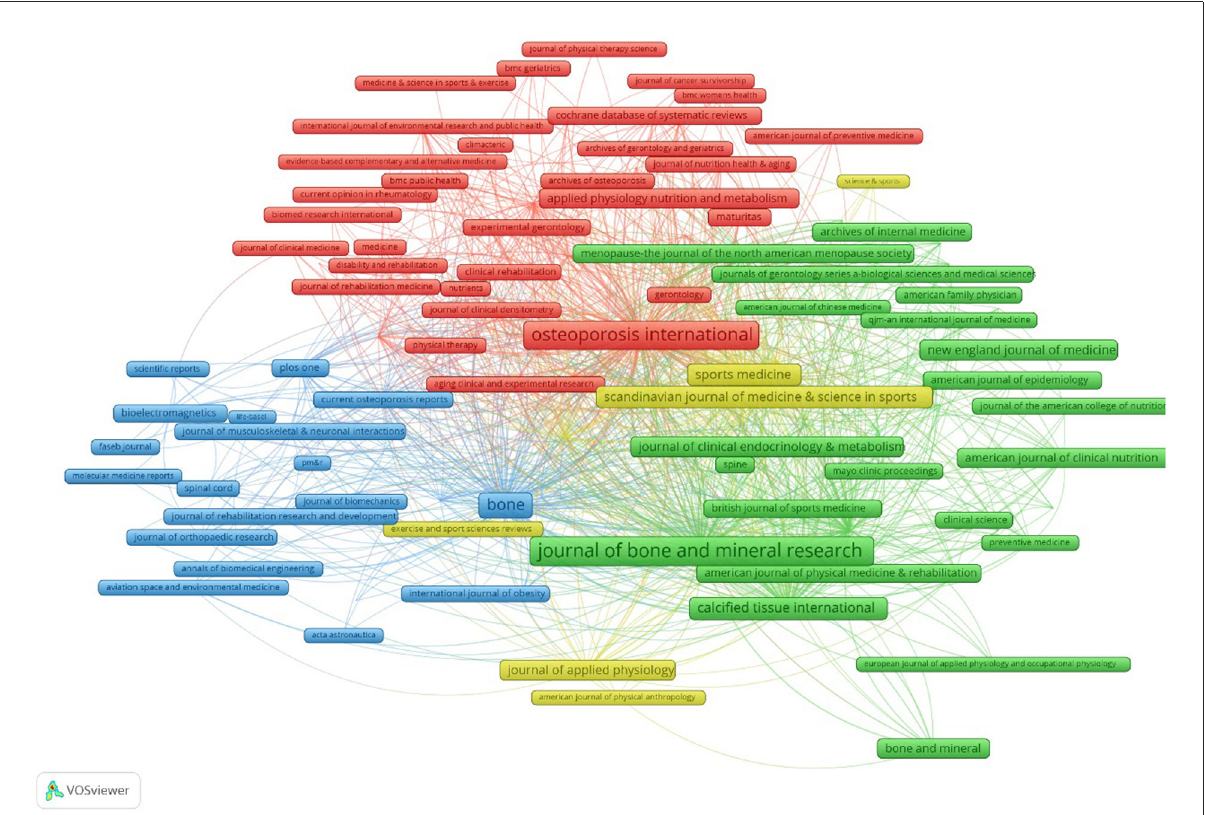
FIGURE4 Bibliographic coupling analysis highly cited journals, weighted by citations, visualized